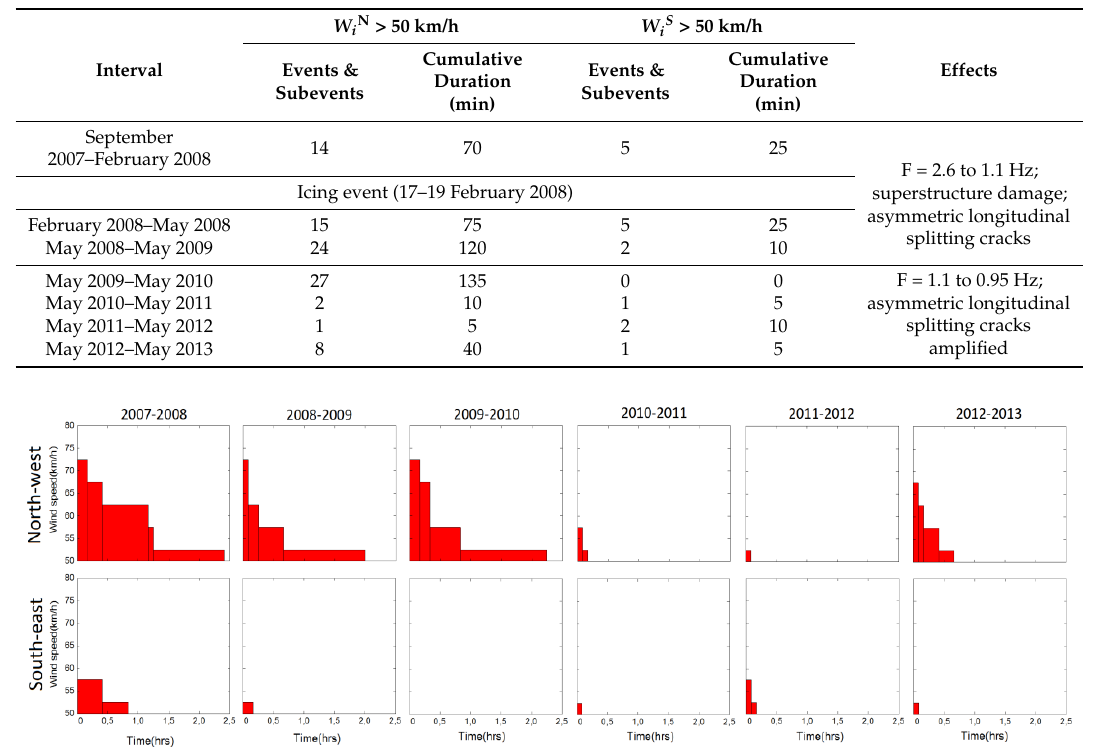
Table 1. Frequency and total duration of wind events/subevents with component >50 km/h normal to the bridge, flowing from northerly (WiN) and southerly (WiS) directions (see also Figure 8). The icing event of 2008 and damage effects are also summarized.